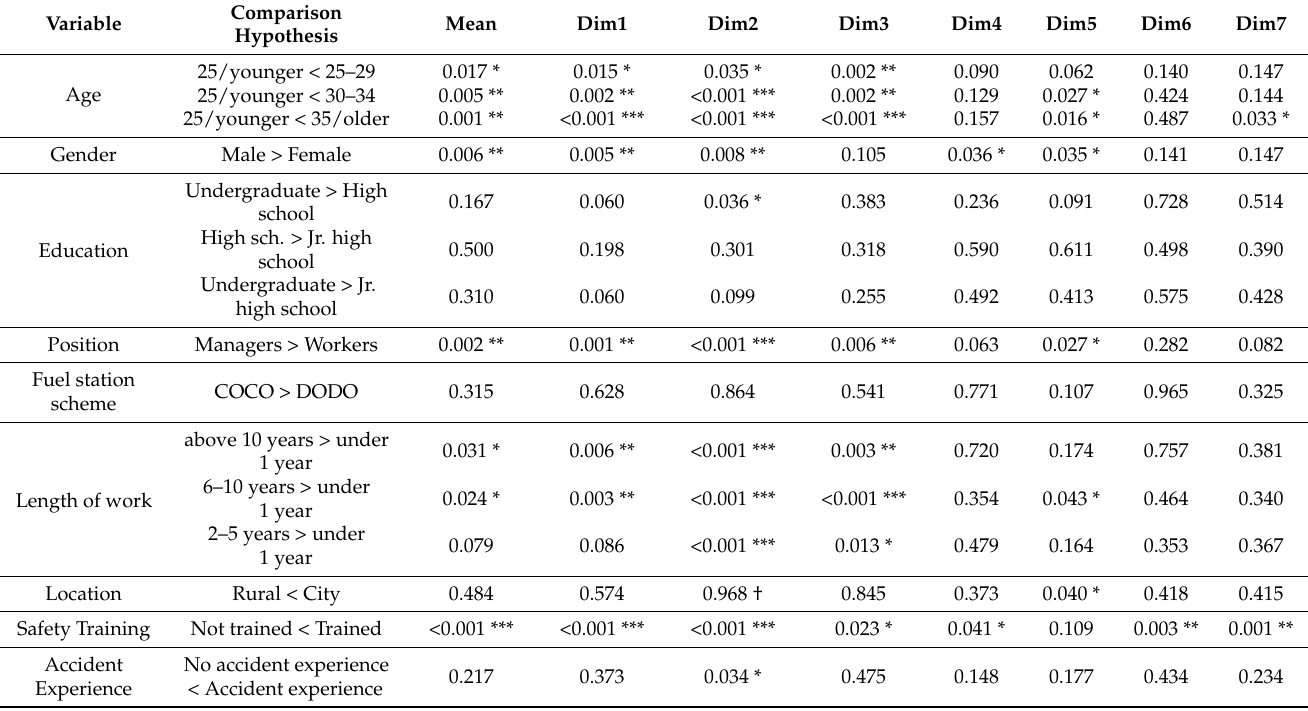
Table 6. Comparison of safety climate scores between different categories of background variable shown as the p -value of the mean and each